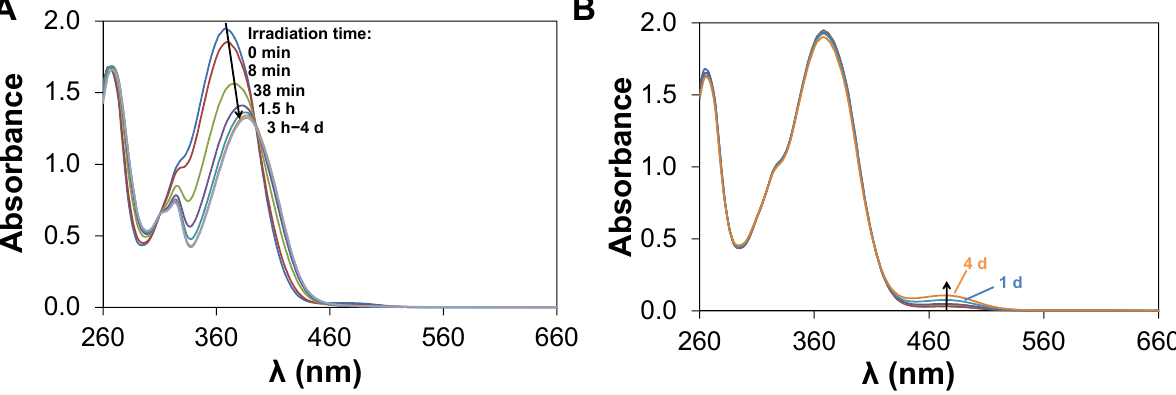
Figure 4. Time-dependent UV-vis spectra of the ligand in DMSO. ( A ) Irradiated continuously with diffuse light. ( B ) Protected from light. [ c ligand = 122 μ M; ℓ = 2 mm; T = 25.0 °C]. 1 H NMR spectra were also recorded for samples protected from light and